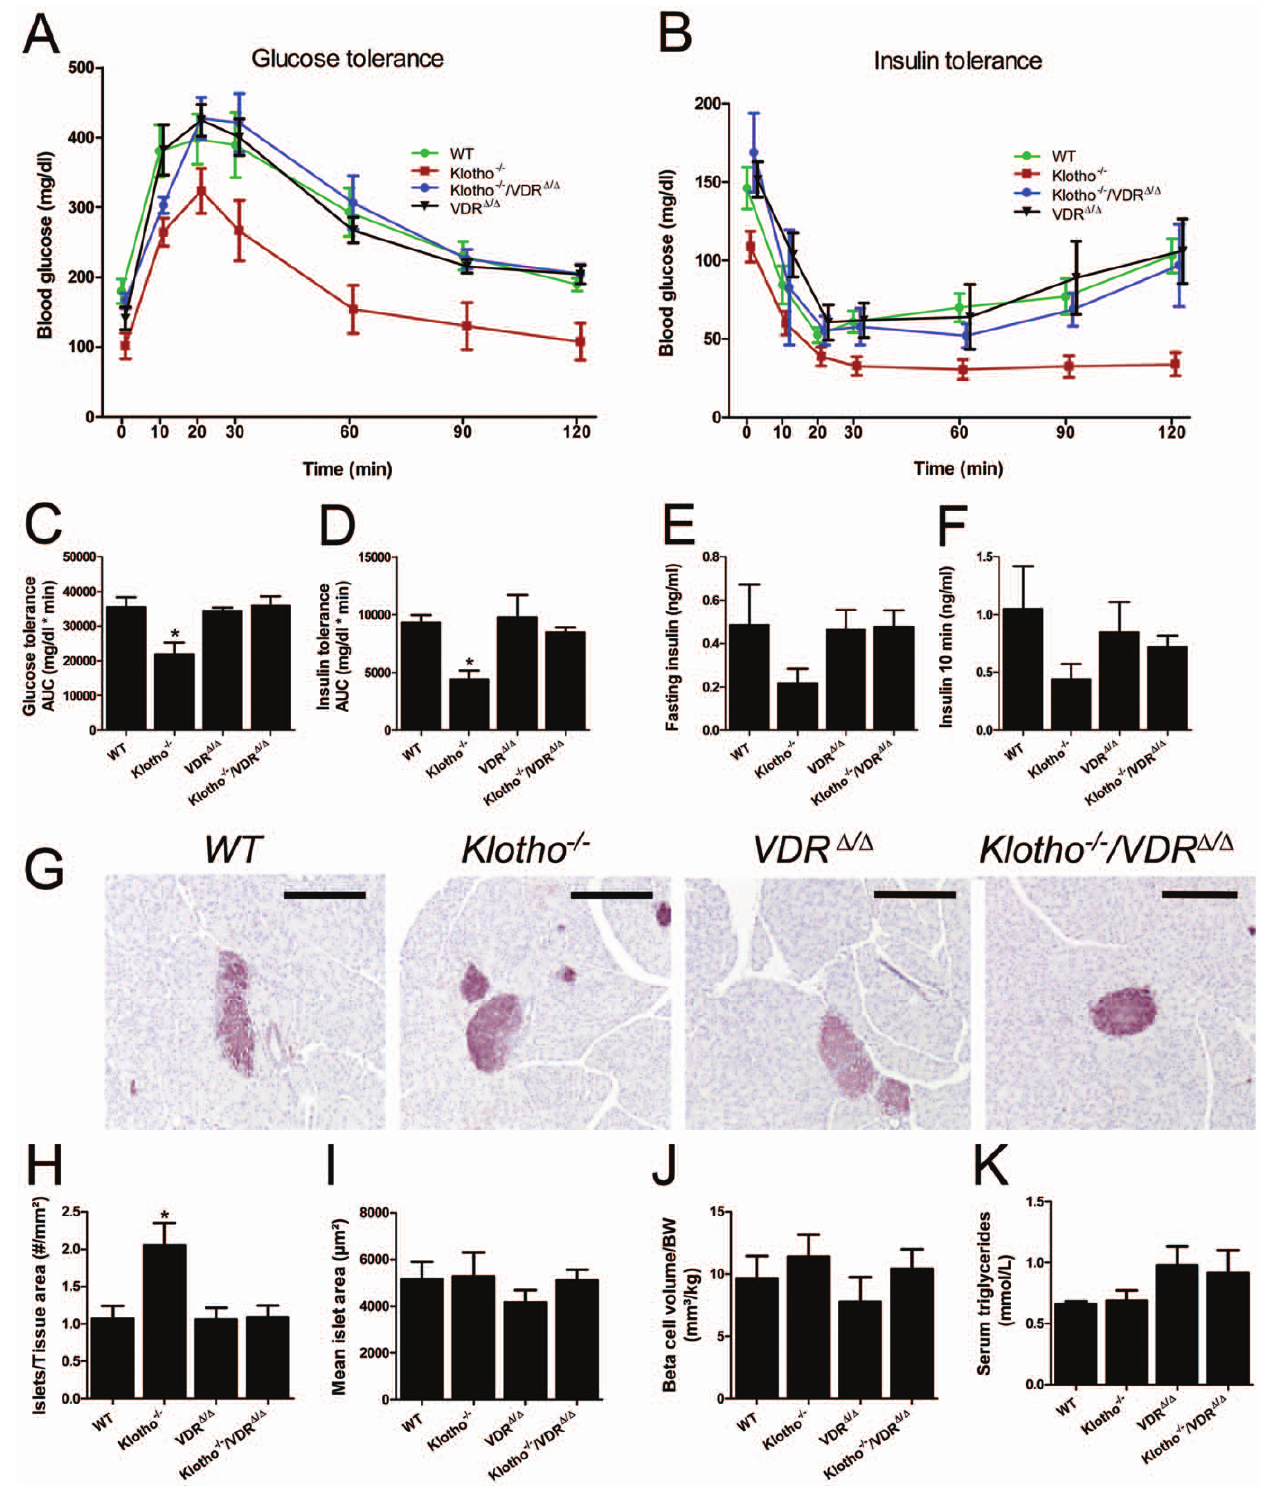
Figure 5. Normalization of increased insulin sensitivity in Klotho 2 / 2 mice by ablation of vitamin D signaling. ( A–D ) Glucose tolerance and insulin tolerance tests in 4-week-old WT , Kl 2 / 2 , VDR D / D , and Kl 2 / 2 /VDR D / D mice show hypoglycemia and profoundly improved glucose tolerance (A, C) and enhanced insulin sensitivity (B, D) in Kl 2 / 2 mice. Ablation of vitamin D signaling in compound mutants completely normalizes glucose and insulin tolerance. The area under the curve (AUC) for glucose and insulin tolerance tests is shown in C and D. Glucose (1.5 mg/g body weight) was administered subcutaneously at time 0 after two hours of fasting. Insulin (0.6 IE/kg) was injected intraperitoneally at time 0. ( E–F ) Fasting insulin and insulin serum levels measured 10 min after a subcutaneous glucose challenge (1.5 mg/g) are not significantly different between the groups, but tend to be lower in Kl 2 / 2 mice. ( G–J ) Histomorphometric analysis of anti-insulin-stained pancreatic paraffin sections (G) shows higher number of islets per tissue area in Kl 2 / 2 compared with WT mice (H), but unchanged mean islet size (I) and beta cell volume per kg BW (J) in all groups of animals. Bar in PLoS ONE |